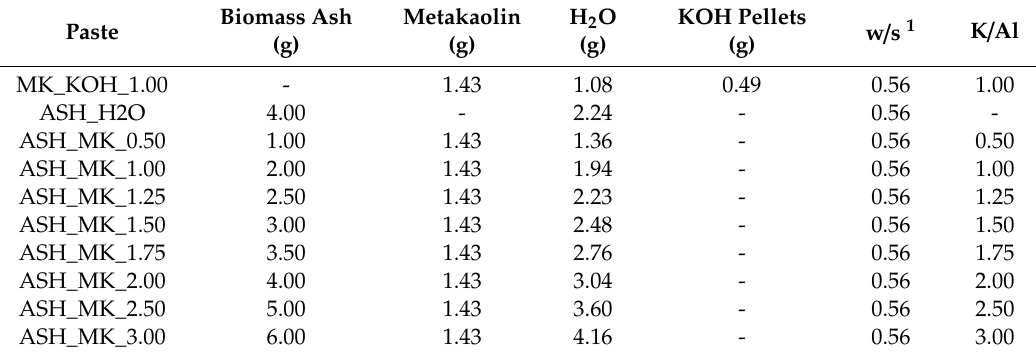
Table 3. Paste compositions for isothermal micro-calorimetry.